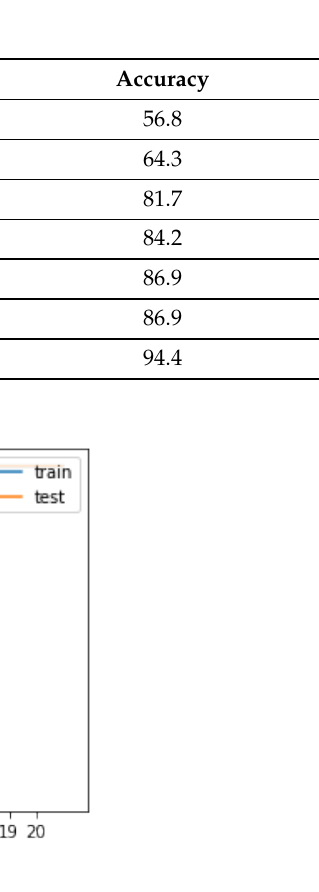
Figure 7. Accuracy of the proposed model during training and testing using IXMAS Dataset.